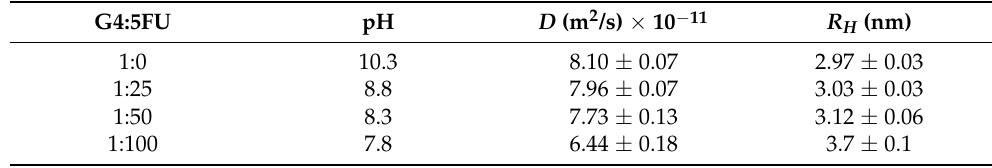
Table 2. The self-diffusion coefficients ( D ) and hydrodynamic radius ( R H ) values of G4PAMAM at